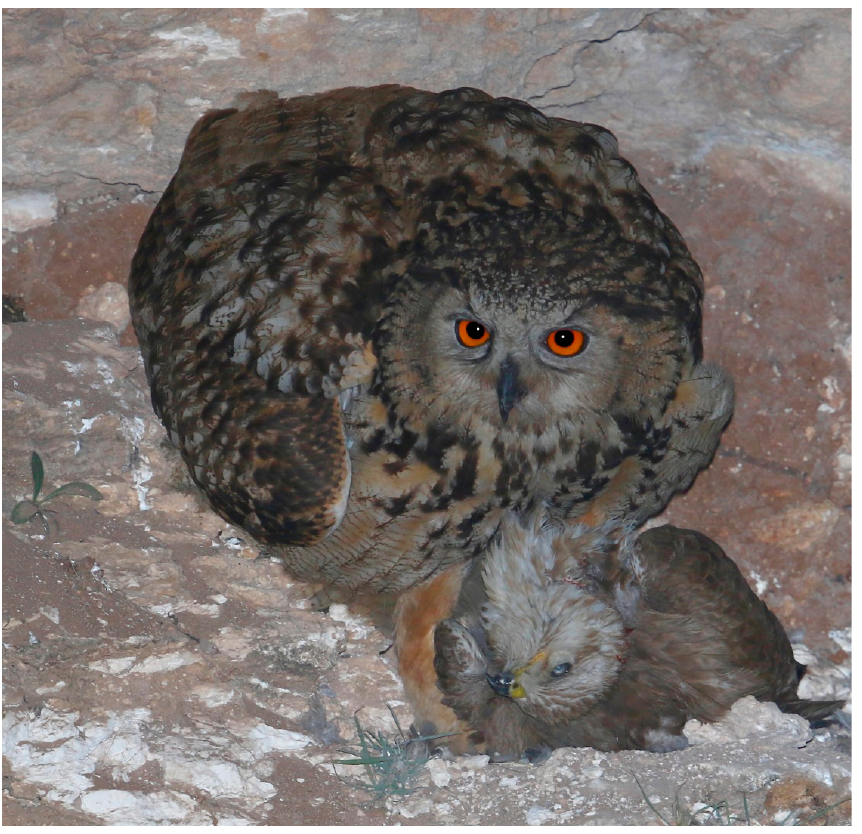
Figure 4. An adult Eagle Owl ( Bubo bubo ) brings a Steppe buzzard ( Buteo b. vulpinus ) to the nest. Photo: Ezra Hadad.